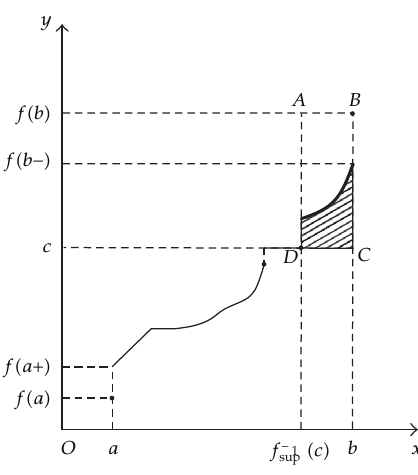
Figure 4: The geometry of the case f (cid:5) a (cid:4) ≤ c ≤ f (cid:5) b − (cid:4)